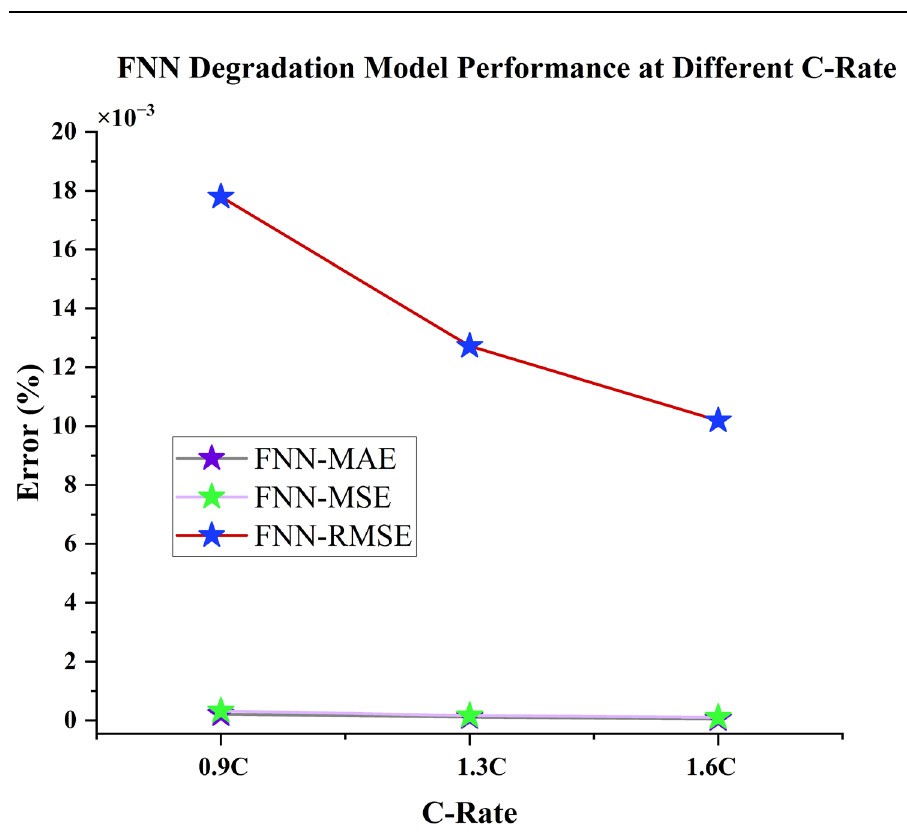
Figure 10. The MAE (%), MSE (%), and RMSE (%) values, achieved with the FNN degradation model at three different accelerated discharging rates: 0.9C, 1.3C, and